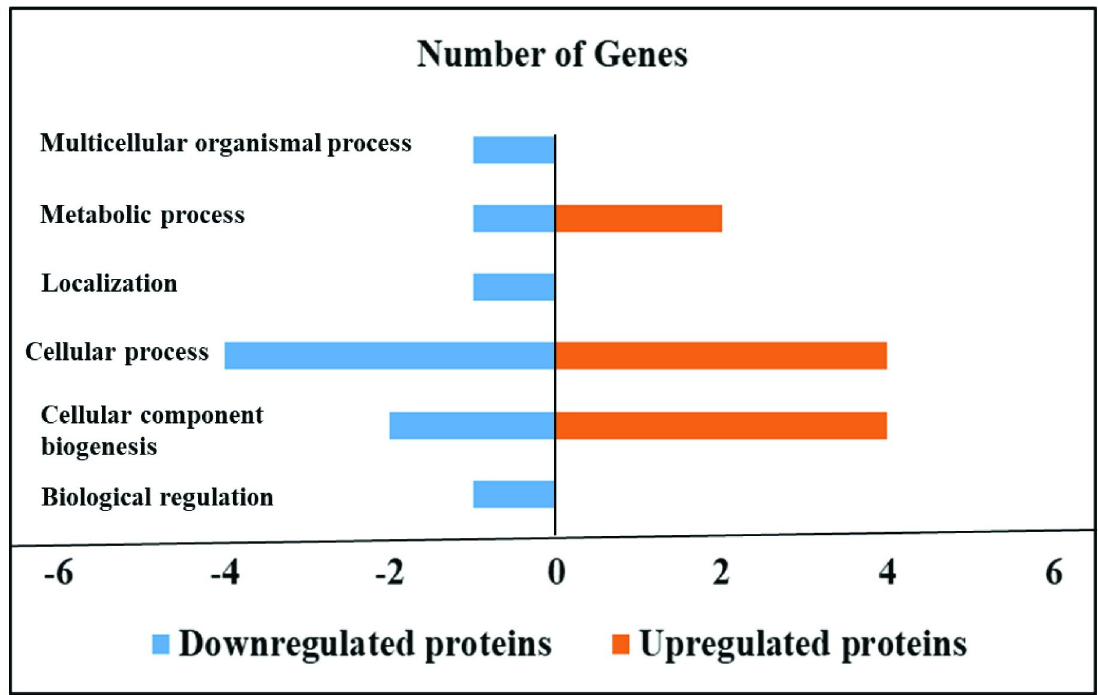
Fig 2. Effect of sodium butyrate on the proteome of HTC cells infected with S . Enteritidis. Sodium butyrate treatment in S . Enteritidis infected HTC cells induced down and upregulated proteins in different biological processes. HTC cells were treated with S . Enteritidis for 4 h in the presence and absence of sodium butyrate, proteins were extracted and analyzed by tandem mass spectrometry. Differentially expressed proteins were calculated using Scaffold software ( P < 0.05) and biological processes were predicted by using STRING and PANTHER software.